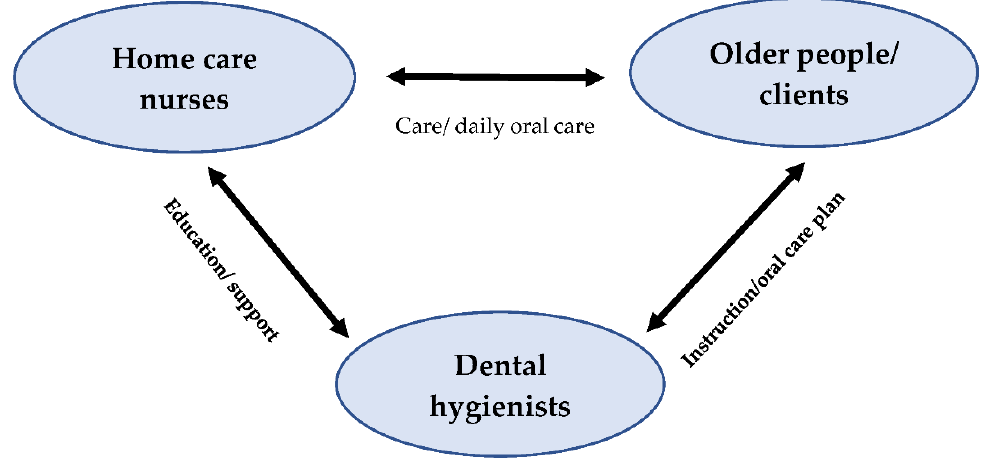
Figure 1. Role of dental hygienists, home care nurses and older people.